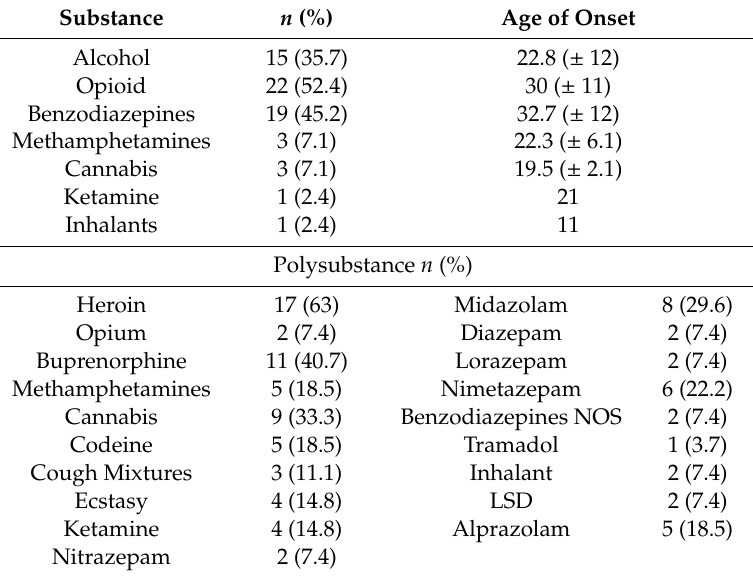
Table 4. Substance use profile